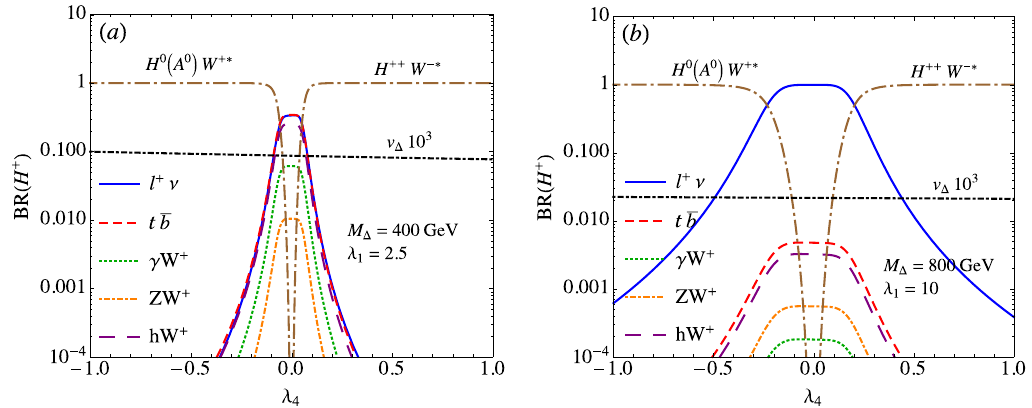
Figure 12 . This legend is the same as that shown in (cid:12)gure 11 with the exception of the H + decays. with w = m 2 =m 2 . It is known that the (cid:21) parameter determines the order of the Higgs i 4 i H (cid:6) triplet masses. Therefore, it is expected that H + can decay to H ++ and H 0 ( A 0 ) through the three-body decay when (cid:21) > 0 and (cid:21) < 0, respectively. Similar to the H ++ ! H + W + 4 4